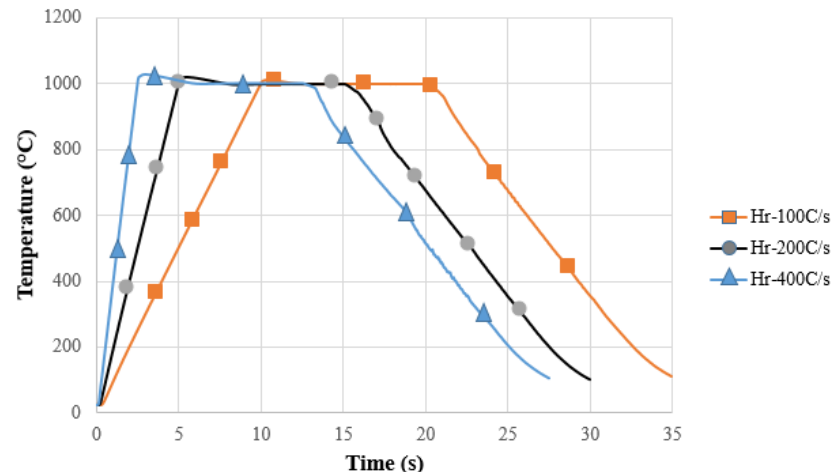
Figure 1. The time-temperature heating-cooling cycles of SLM IN718 specimens with three heating-up rates to achieve 1000 °C and a dwell time of 10 s and a final identical quenching constant rate of 65 °C/s.